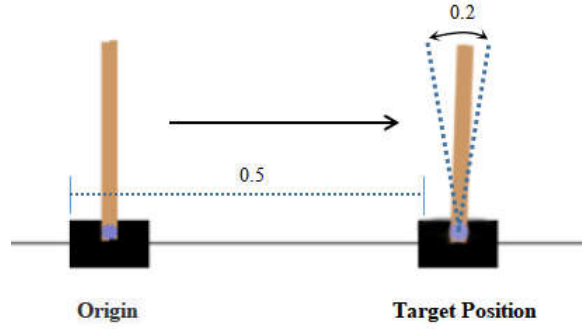
Figure 5. Description of cart pole comparison task.